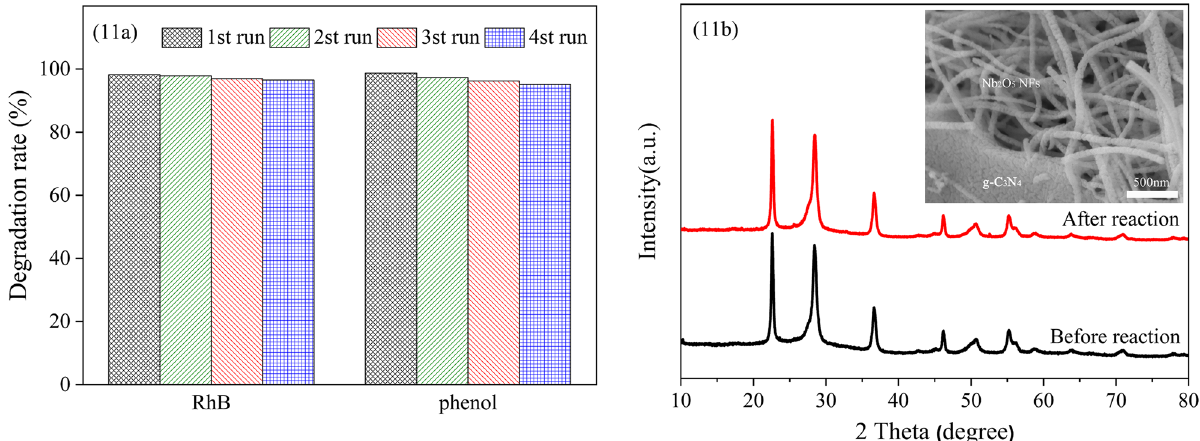
Figure 11. ( a ) The reusability of g-C 3 N 4 /Nb 2 O 5 heterojunction: photodegradation of RhB and phenol. ( b ) XRD patterns of g-C 3 N 4 /Nb 2 O 5 heterojunction before and after photodegradation, and a typical SEM image (inset) of g-C 3 N 4 /Nb 2 O 5 heterojunction after the